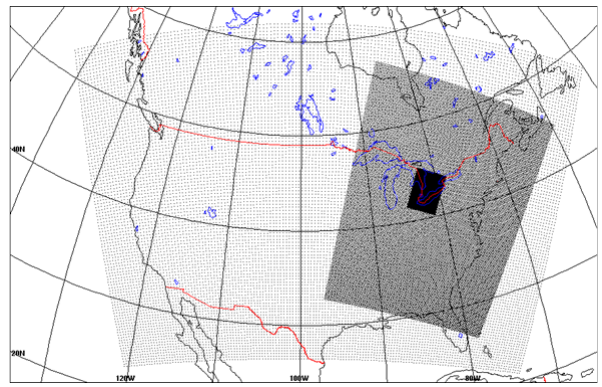
Fig. 2. AURAMS nested grid configuration for BAQS-Met simula- tions. Outermost grid has a horizontal grid spacing of 42km. Inner grids have horizontal grid spacings of 15 and 2.5km,